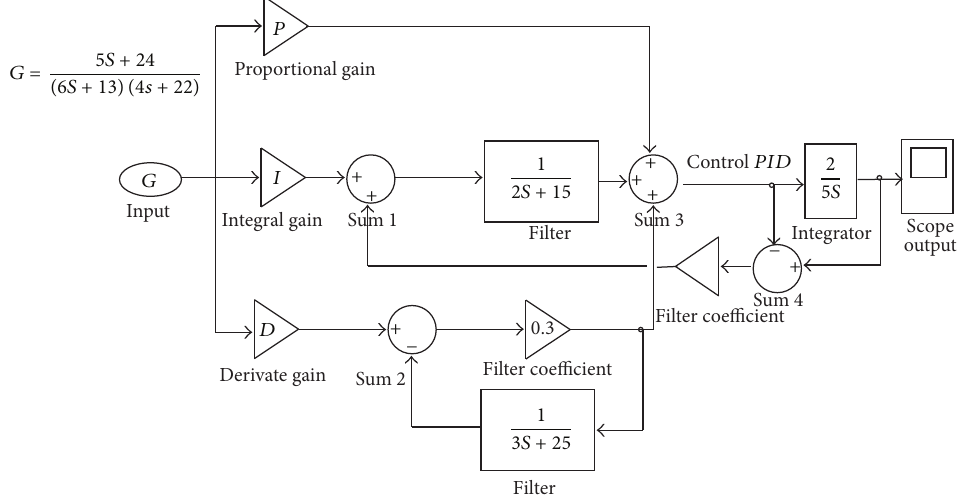
Figure 2: Diagram of the functionality of the proposed material for the manufacturing of the biomechanical